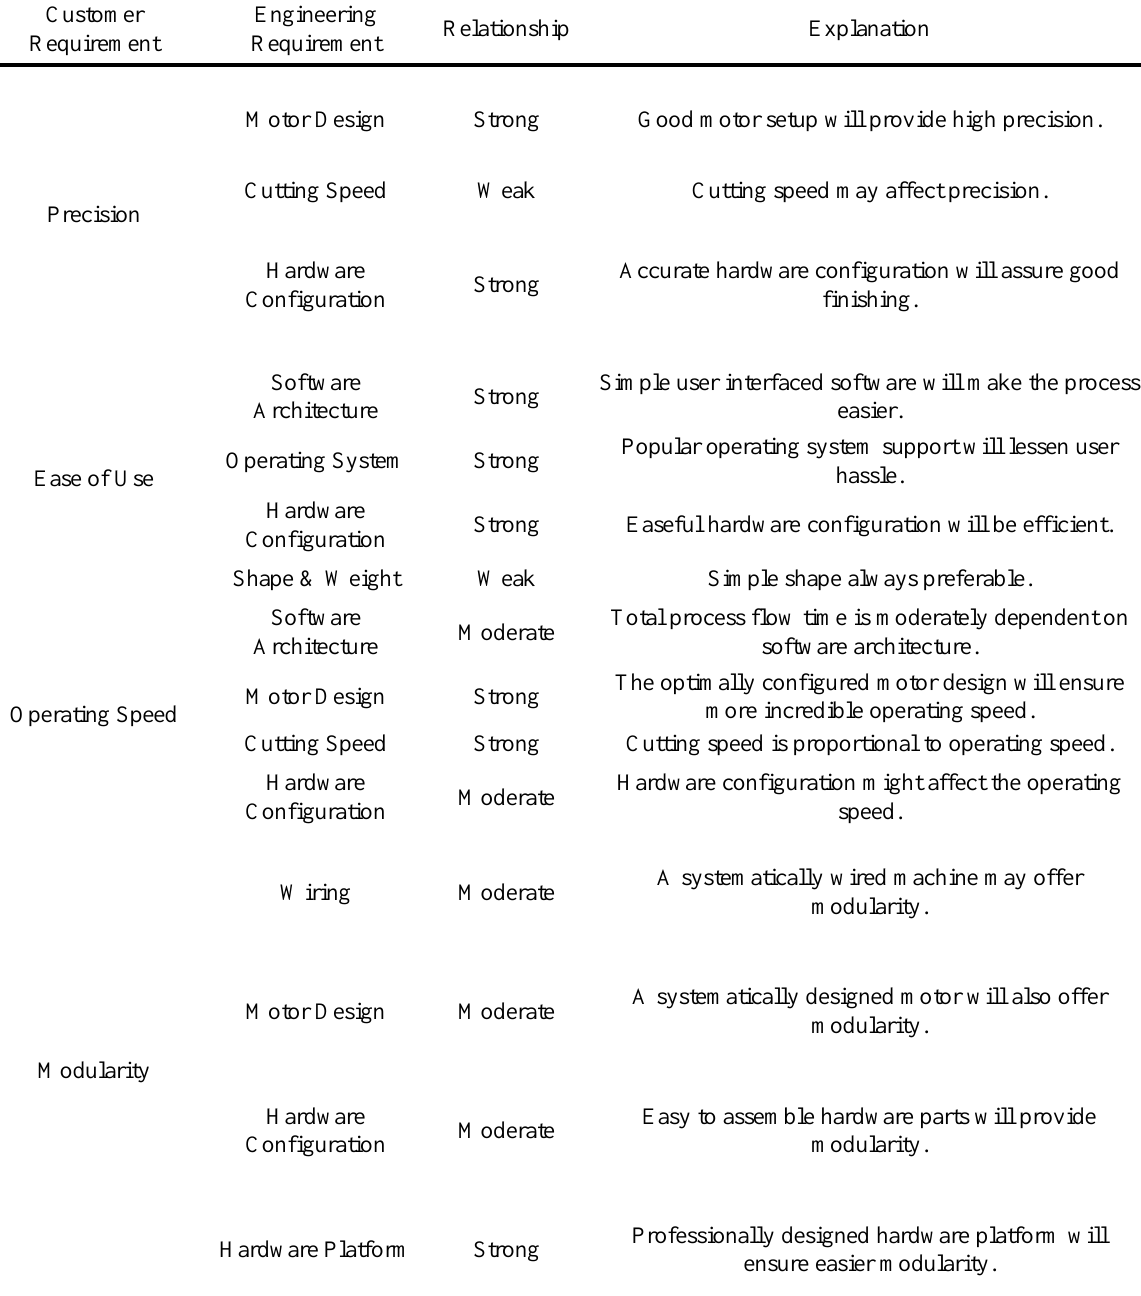
Table 1. Table explaining the relationship between the customer and technical